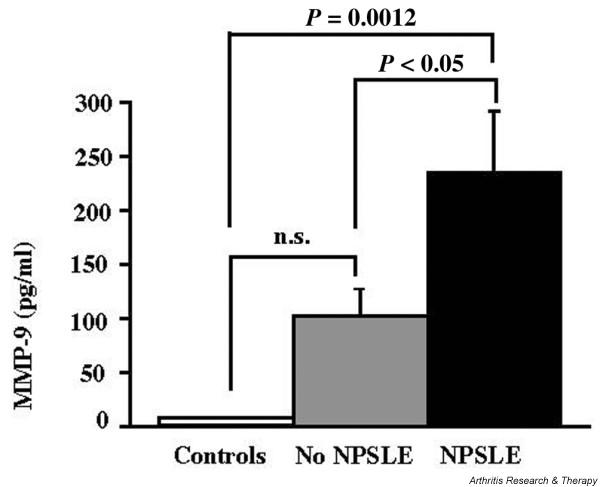
Cerebrospinal fluid expression of active matrix metalloproteinase (MMP)-9 in patients with systemic lupus erythematosus with (NPSLE) and without (No NPSLE) central nervous system involvement, and in cerebrally healthy control individuals.